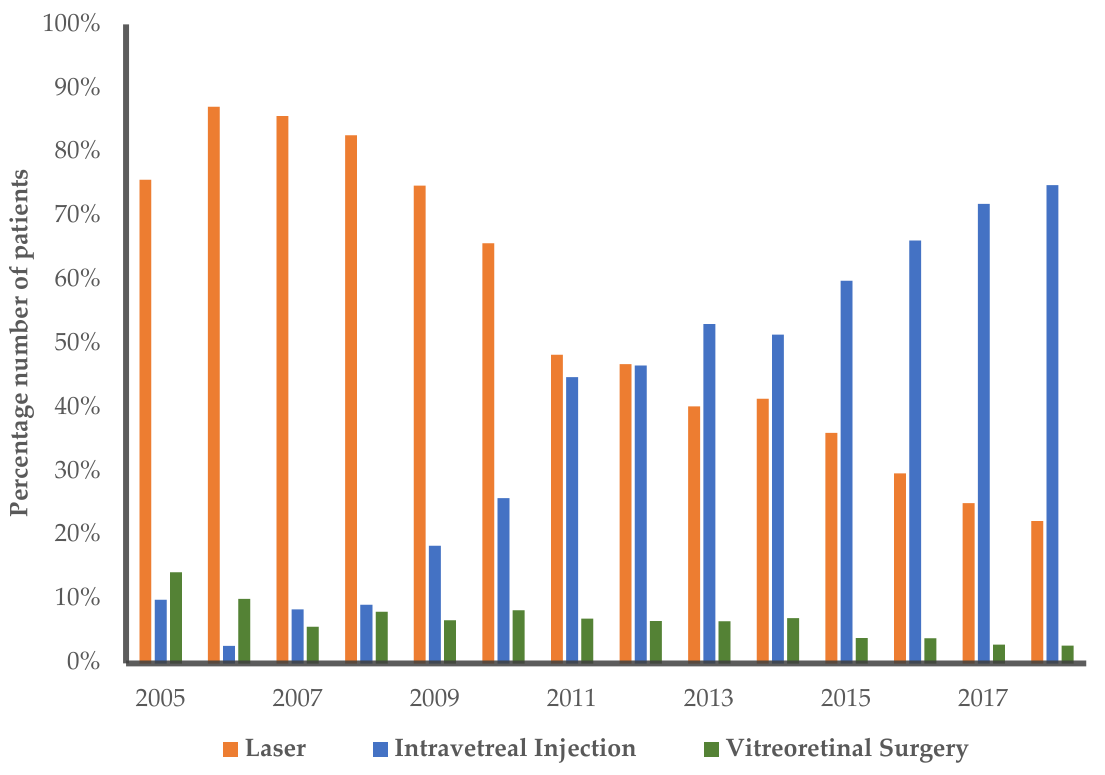
Figure A2. Percentage of the number of patients with diabetic retinopathy being treated with the different treatment modalities per year.